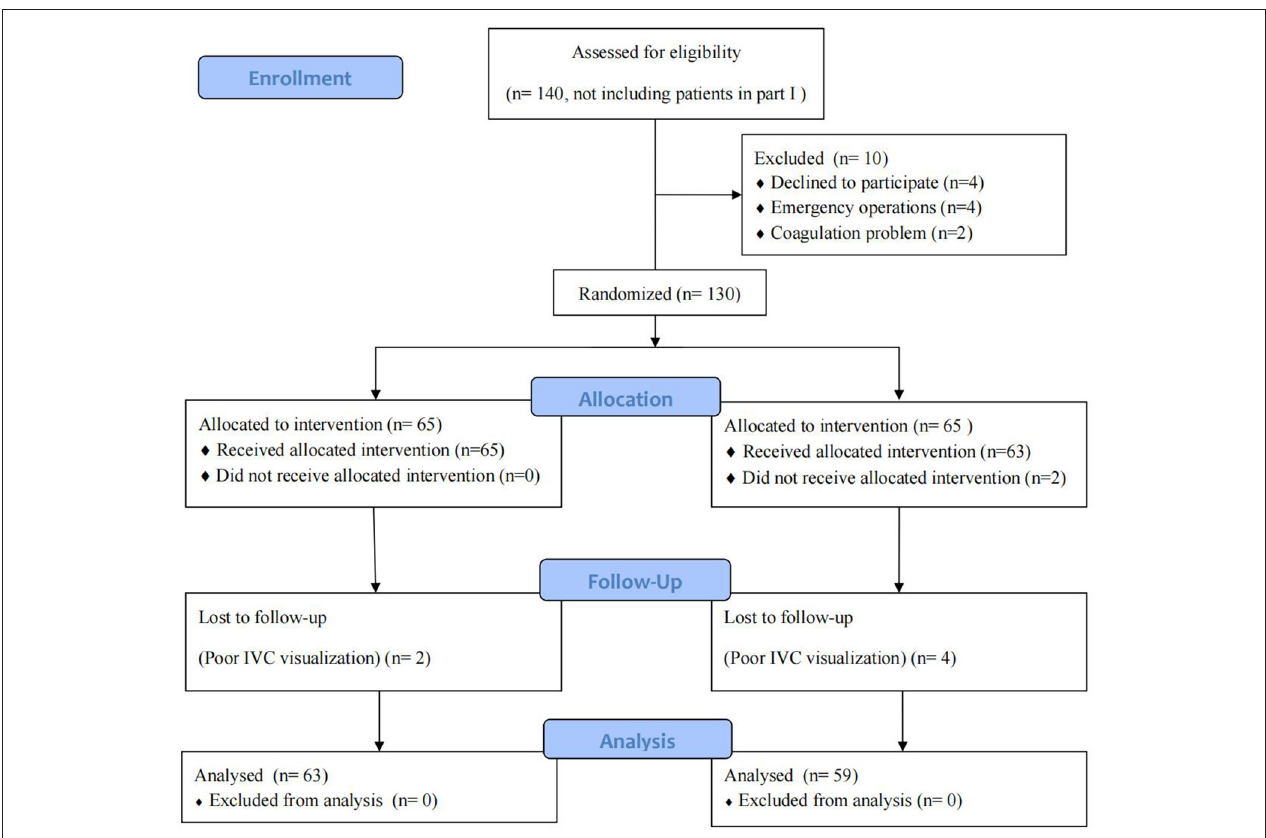
FIGURE 3 | Flow diagram outlining the enrollment and randomization study